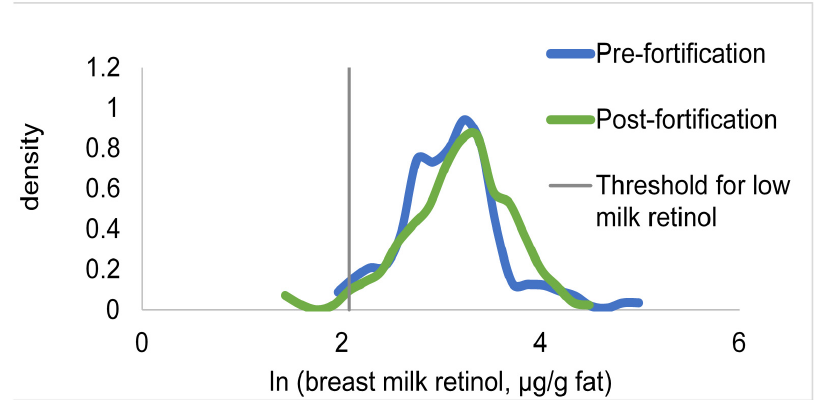
Figure 2. Kernel density distributions of breast milk vitamin A concentration (expressed as µ g/g fat and subjected to natural logarithm transformation) among a representative sample of breastfeeding women in Yaound é and Douala, Cameroon, two years before and one year after the introduction of vitamin A-fortified cooking oil through a mandatory national program. Breast milk vitamin A concentration is compared to the cutoff for low milk vitamin A concentration, 8 µ g/g